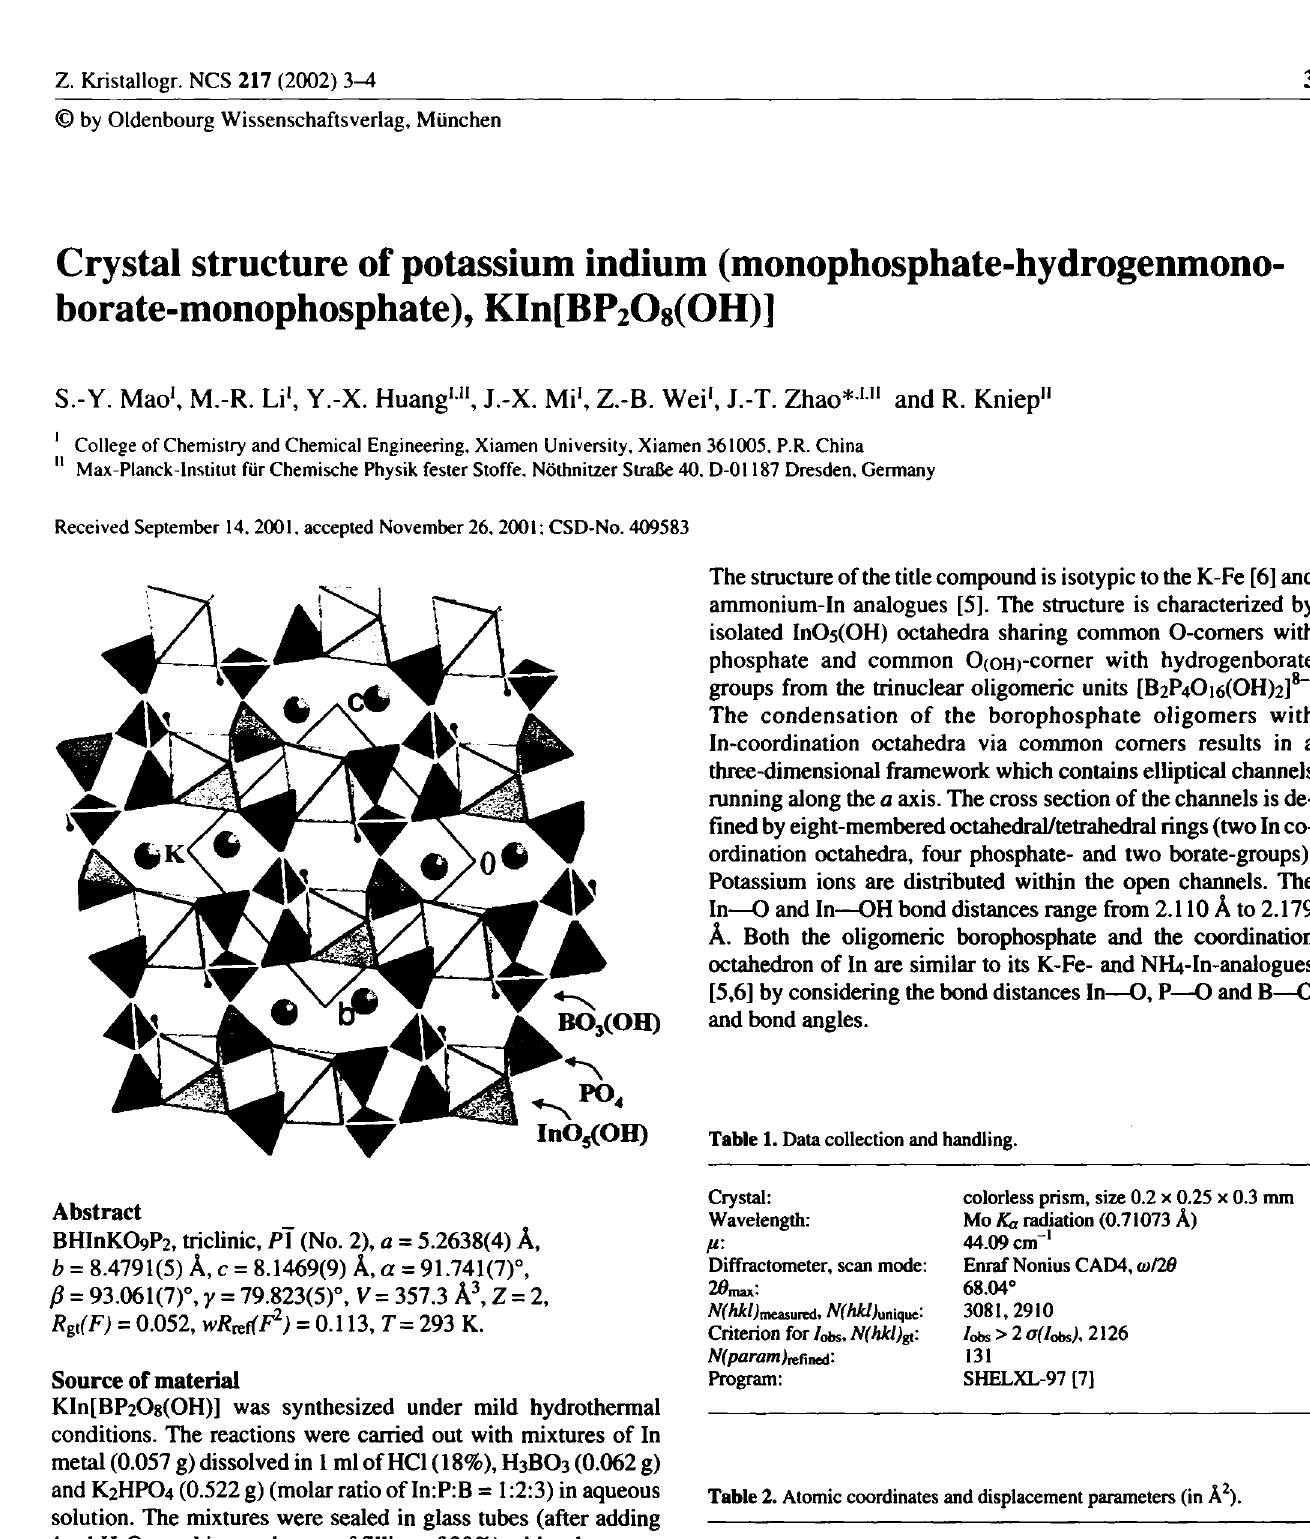
Table 2. Atomic coordinates and displacement parameters (in A 2